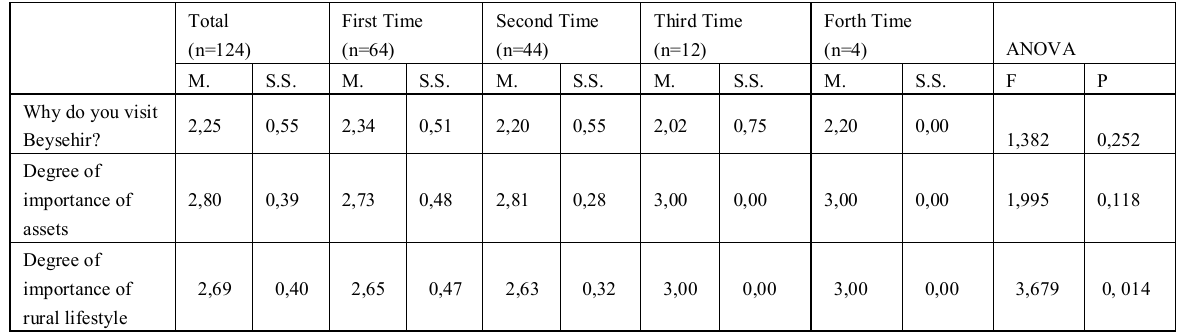
Table 8: Effect of number of visits to different